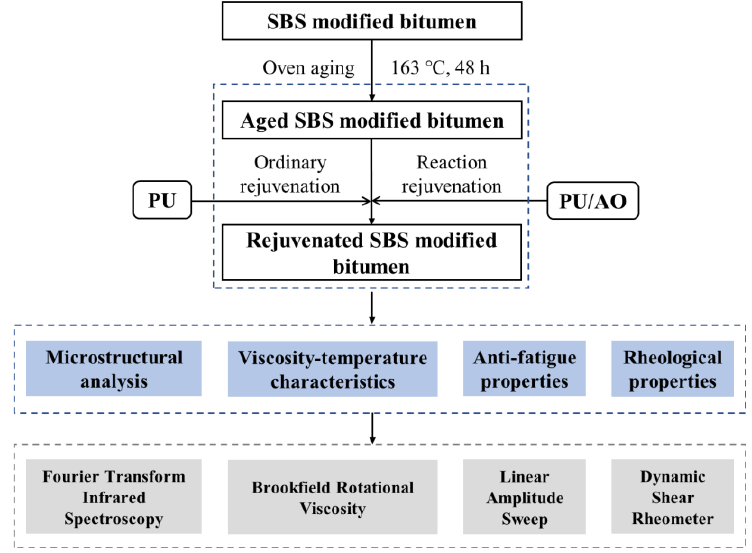
Figure 1. Research flowchart of this study.